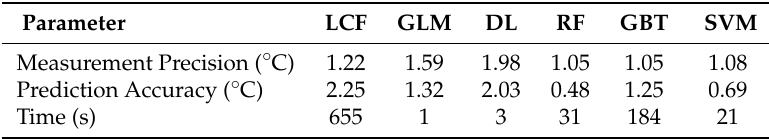
Table 1. Summary of the model